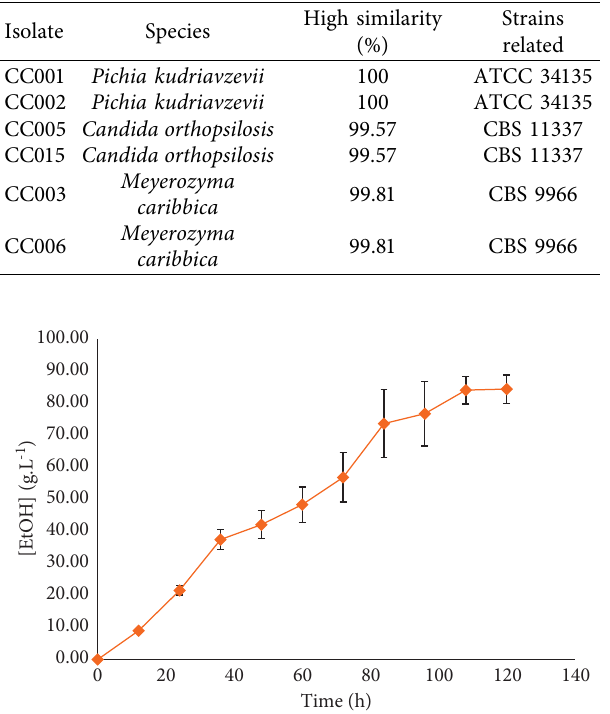
Figure 1: Ethanol production by Meyerozyma caribbica CC003 along 120h of fermentation. The stationary phase was observed after 108h. Error bars indicate standard